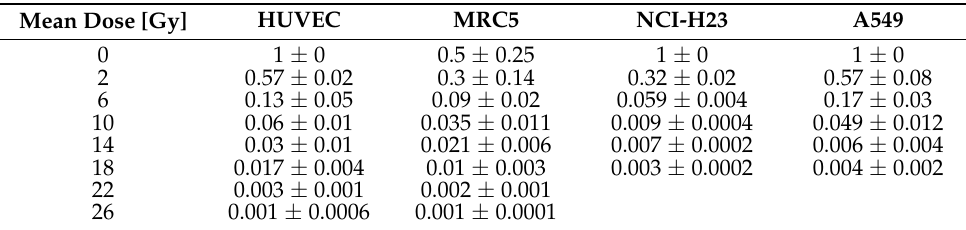
Table A2. Microbeam cell survival data for the four cell lines used. Mean values and standard deviations of three independent repeat experiments are reported.